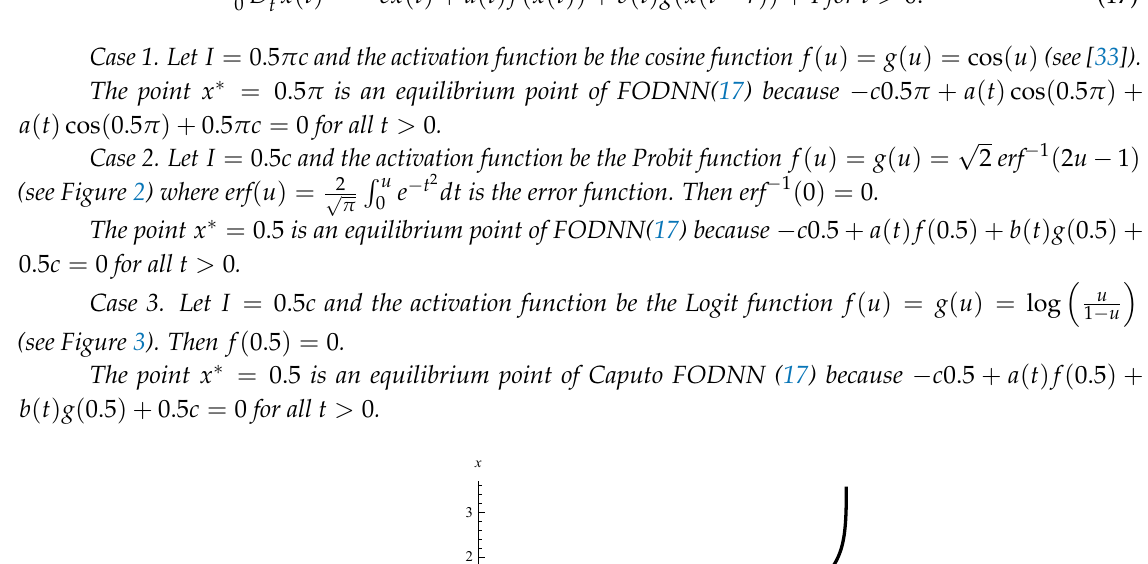
Figure 2. Example 5. Graph of the function f ( t ) =